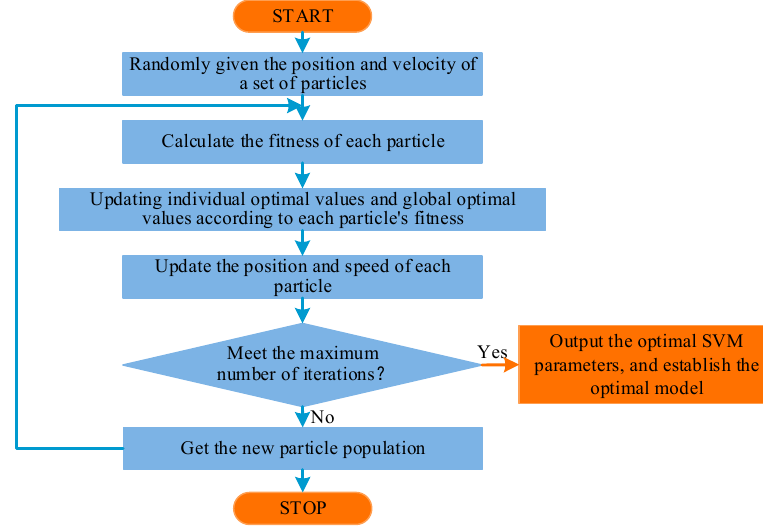
Figure 5. Optimal parameter selection of SVM based on the PSO algorithm.